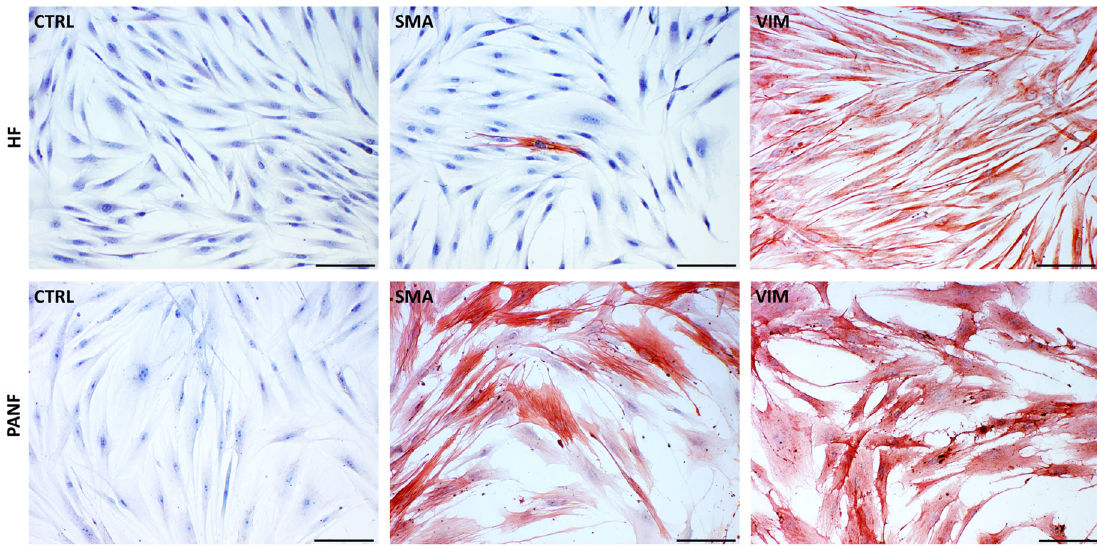
Figure 1. Detection of α -smooth muscle actin (SMA) and vimentin (VIM) in normal human dermal fibroblasts (HFs) and CAFs isolated from pancreatic ductal adenocarcinoma (PANF). Negative controls (CTRL) are also included. The bar is 100 μ m.